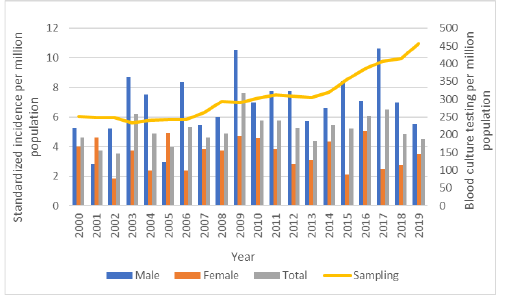
Figure 1. Standardized annual incidence of Aeromonas species bloodstream infections in Queensland, Australia, 2000 – 2019